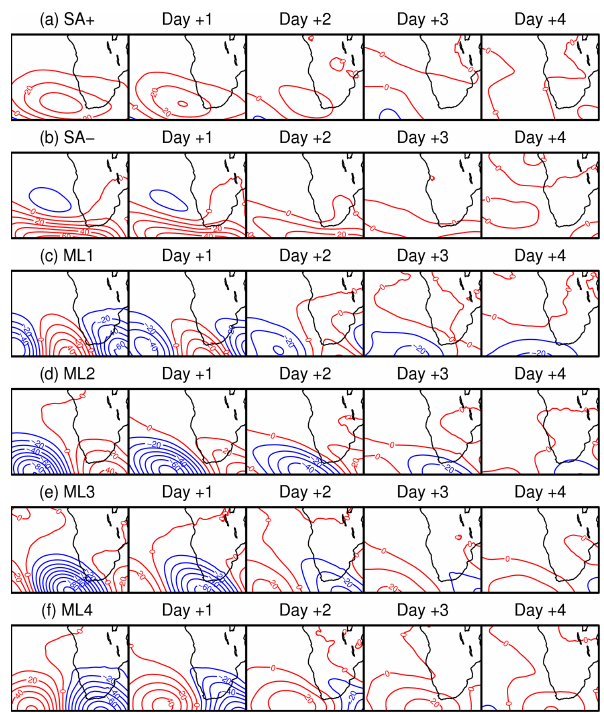
Figure 6. Daily evolution of the 700hPa geopotential height anomalies (m, contours) associated with the CAMS WR classifi- cation, computed as composites from the WR occurrence (day 0) to day + 4.